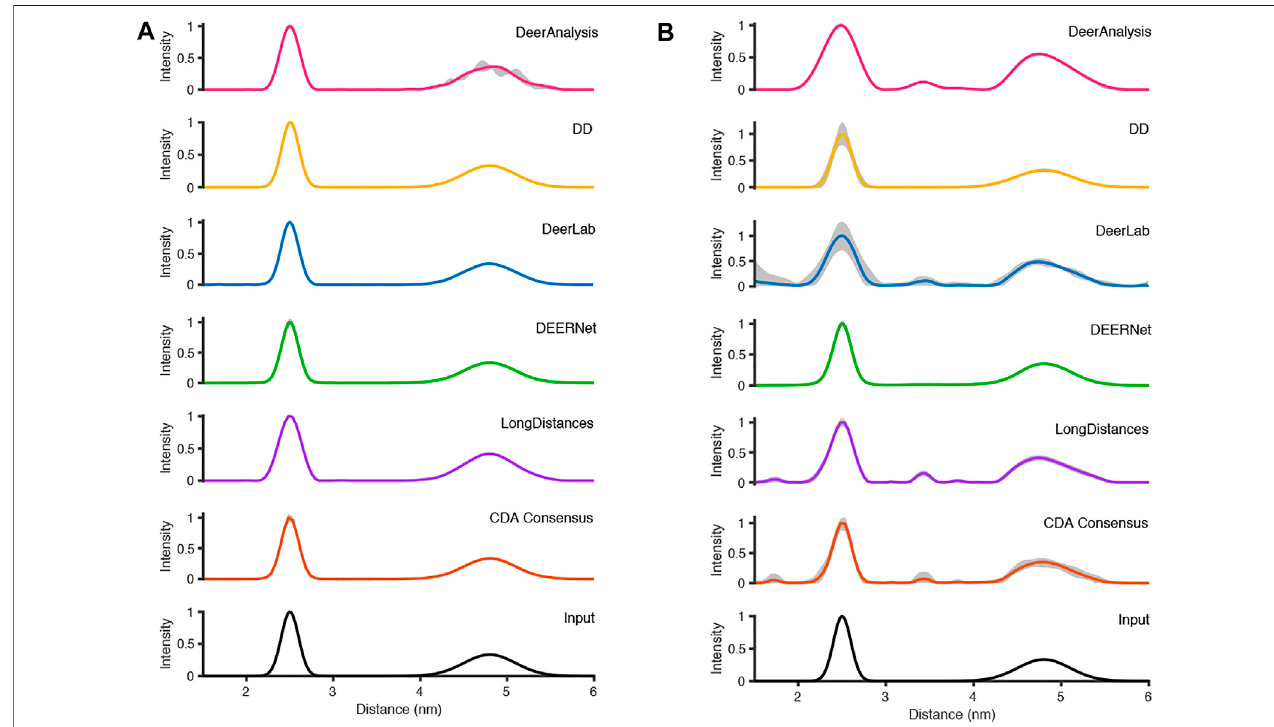
FIGURE 7 | The analysis of the simulated DEER time traces using the various analysis packages (CDA Consensus is the consensus result from ComparativeDeerAnalyzer) and the original input distance distributions are shown at the bottom: (A) noiseless data; (B) noisy data.